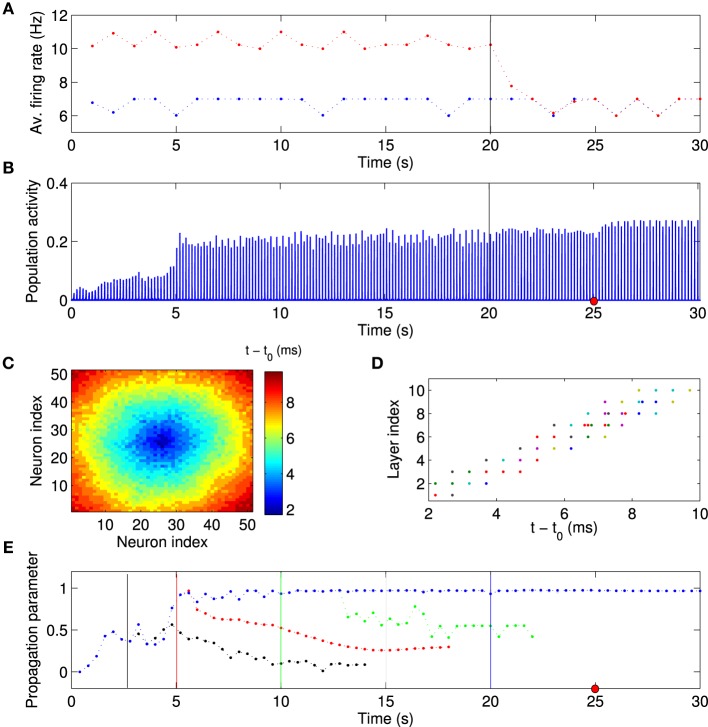
Synchronous activity propagation persists after local excitation is removed. (A) Average firing rate of background neurons (blue points) and high-frequency neurons (red points) as a function of time. After the network has reached the stationary state, the local excitation is removed at t = 20 s (vertical line), i.e., the high-frequency neurons receive an input current from the same distribution as the other neurons in the network. Despite this manipulation, (B) the network activity remains highly synchronized and the activity propagation remains stable (C–E). (C,D) Example of spike times, taken at the time indicated by the red dot in (B). (E) If anything, the activity propagation appears to be more stable since there are smaller fluctuations in the propagation parameter (blue data points). The same analysis was performed with the local excitation removed at different times as indicated by the vertical lines (black, red, green, and blue). When the local excitation is removed at earlier time points, activity propagation destabilizes. This simulation used the same network parameters as the one shown in Figure 6. Visual inspection suggests that the feedforward parameter (Figure 6A) determines whether activity propagation remains stable after the local excitation has been removed. If the network structure is feedforward, including the first layer, i.e., the feedforward parameter is larger than about 0.75, then stable synfire-chain- like propagation remains stable after learning.